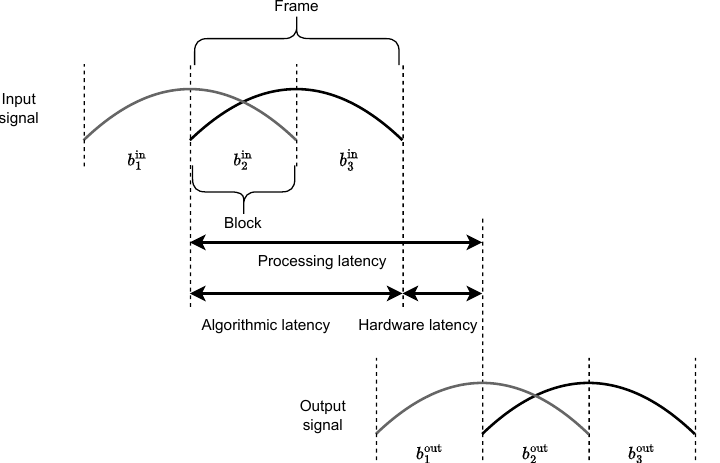
Figure 1. Illustration of processing in frames, where b in b out , b out , b out are the output 2 3 1